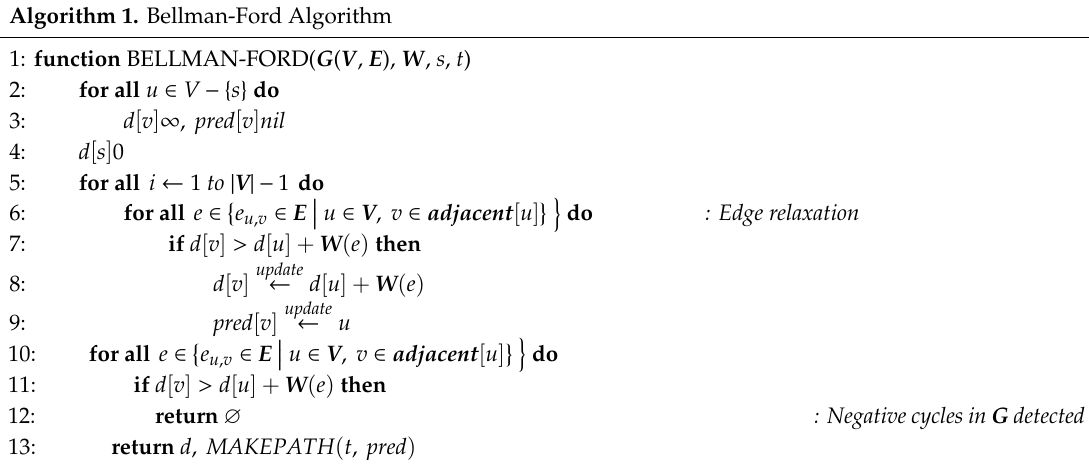
Algorithm 1. Bellman-Ford